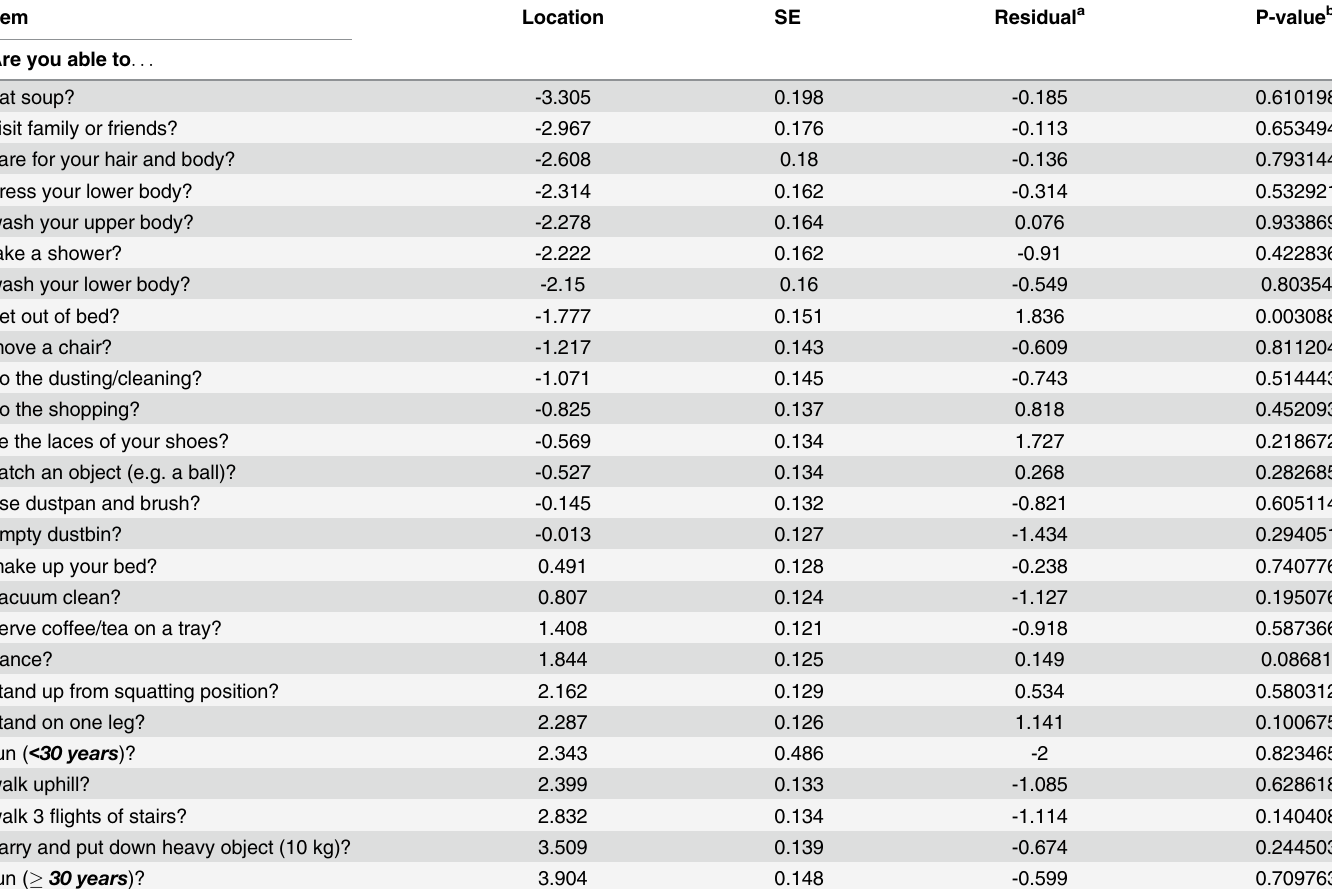
Table 2. DM1- Activ C